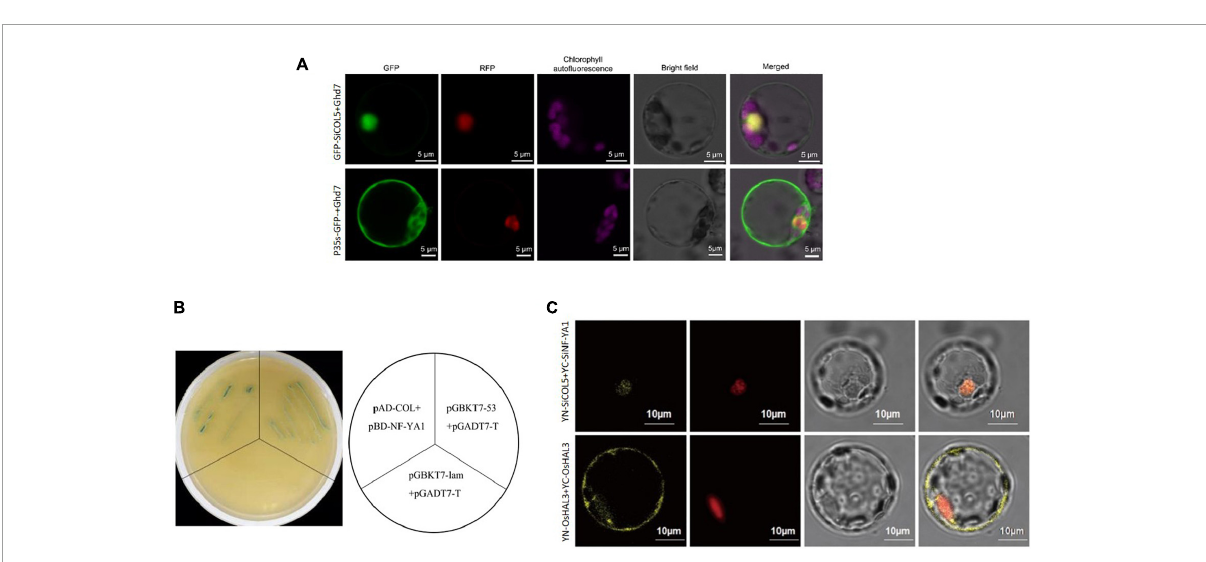
FIGURE7 Interaction between SiCOL5 and SiNF-YA1 in the nucleus. (A) Subcellular localization of SiCOL5. (B,C) Interaction between SiCOL5 and SiNF-YA1 in a yeast two-hybrid assay (B) and bimolecular fluorescence complementation assay (C) . Scale bar = 10 µ